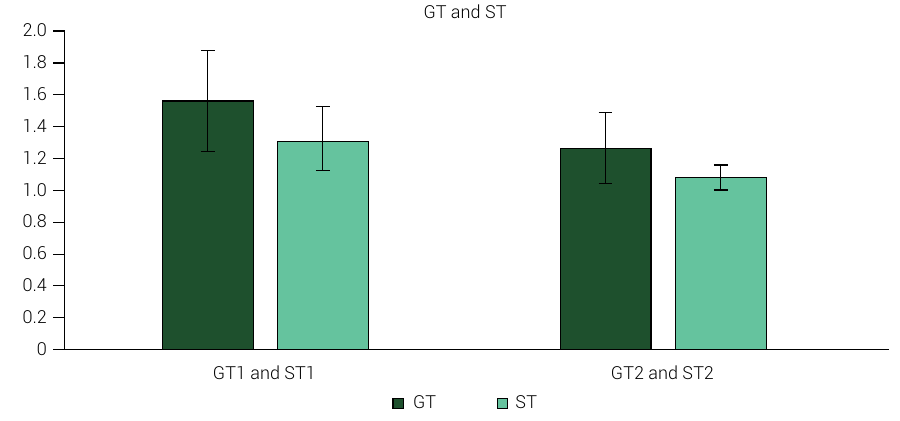
Figure 5. Bar chart representing GT 1&2 vs ST